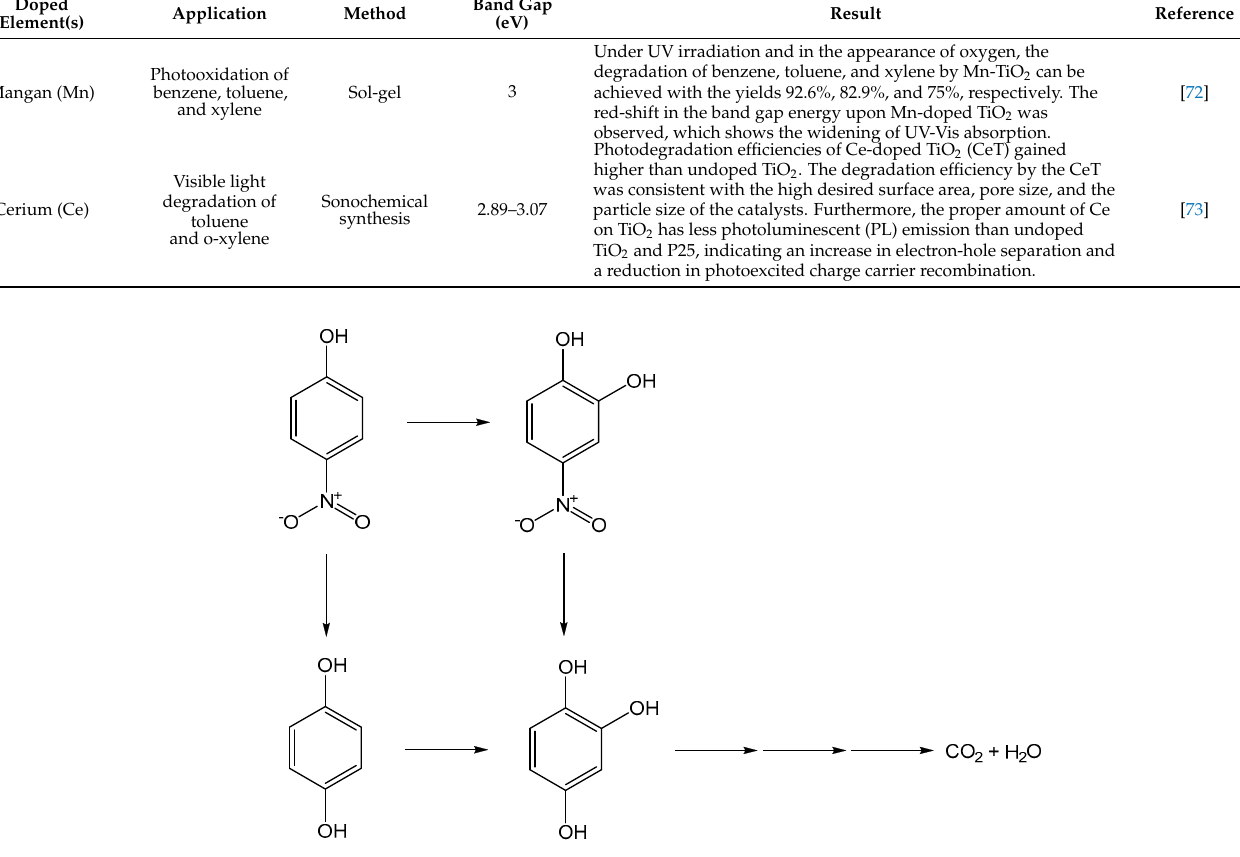
Figure 7. Route of 4-NP degradation by B-doped TiO 2 under UV irradiation, adapted from